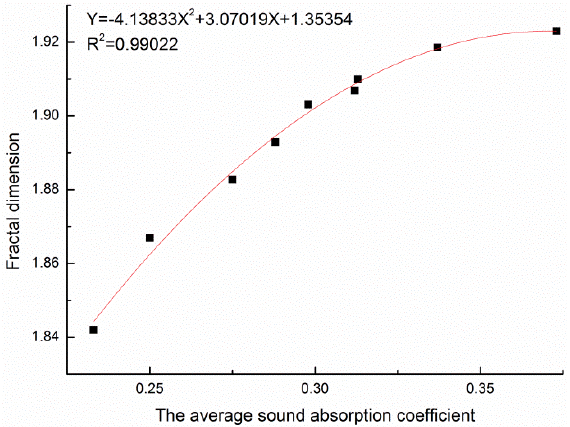
Figure 11. Relationship between fractal dimension and average sound absorption coefficient.